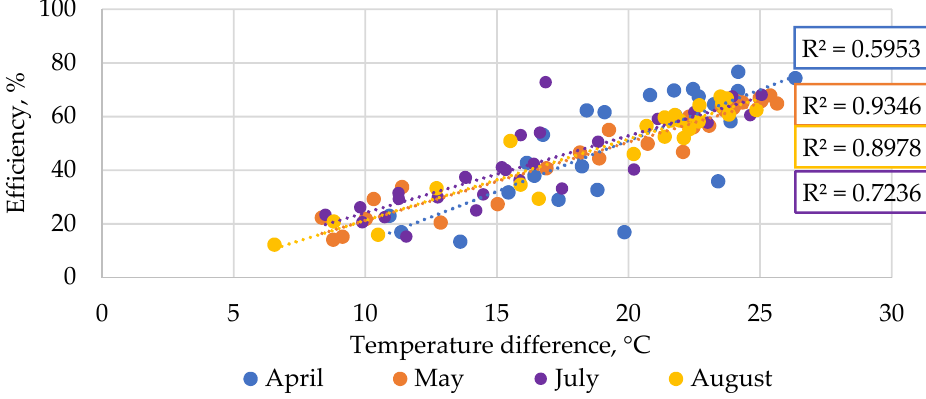
Figure 6. Solar collector efficiency dependency on temperature difference.